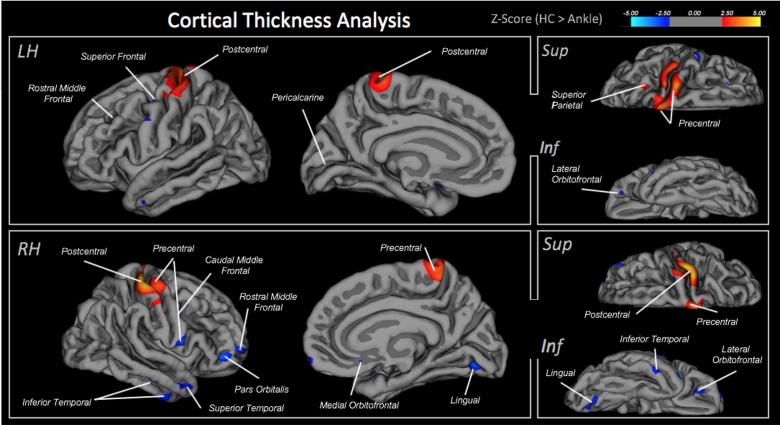
Cortical thickness measures. Comparing cortical thickness between the healthy control and ankle injury cohorts. Each highlighted brain region depicts a significant difference between subject groups at the FDR-corrected level of 0.05. Red = greater thickness in healthy controls; Blue = greater thickness in ankle injury cohort. All significant brain regions are ported in the table below along with the size of the cluster and center of gravity reported in Talairach coordinates. (For interpretation of the references to color in this figure legend, the reader is referred to the web version of this article.)